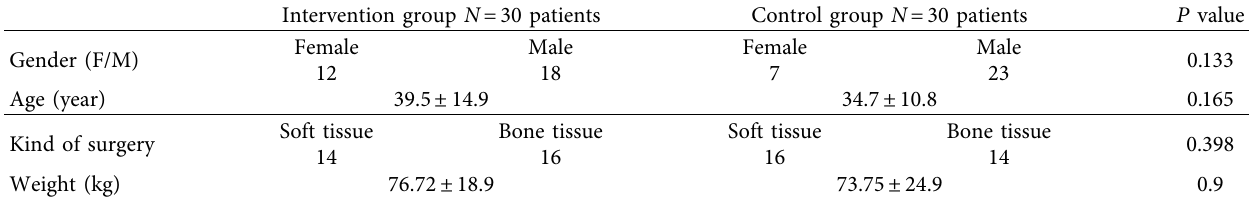
Table 1: Studied patients’ demographic data and surgical characteristics.